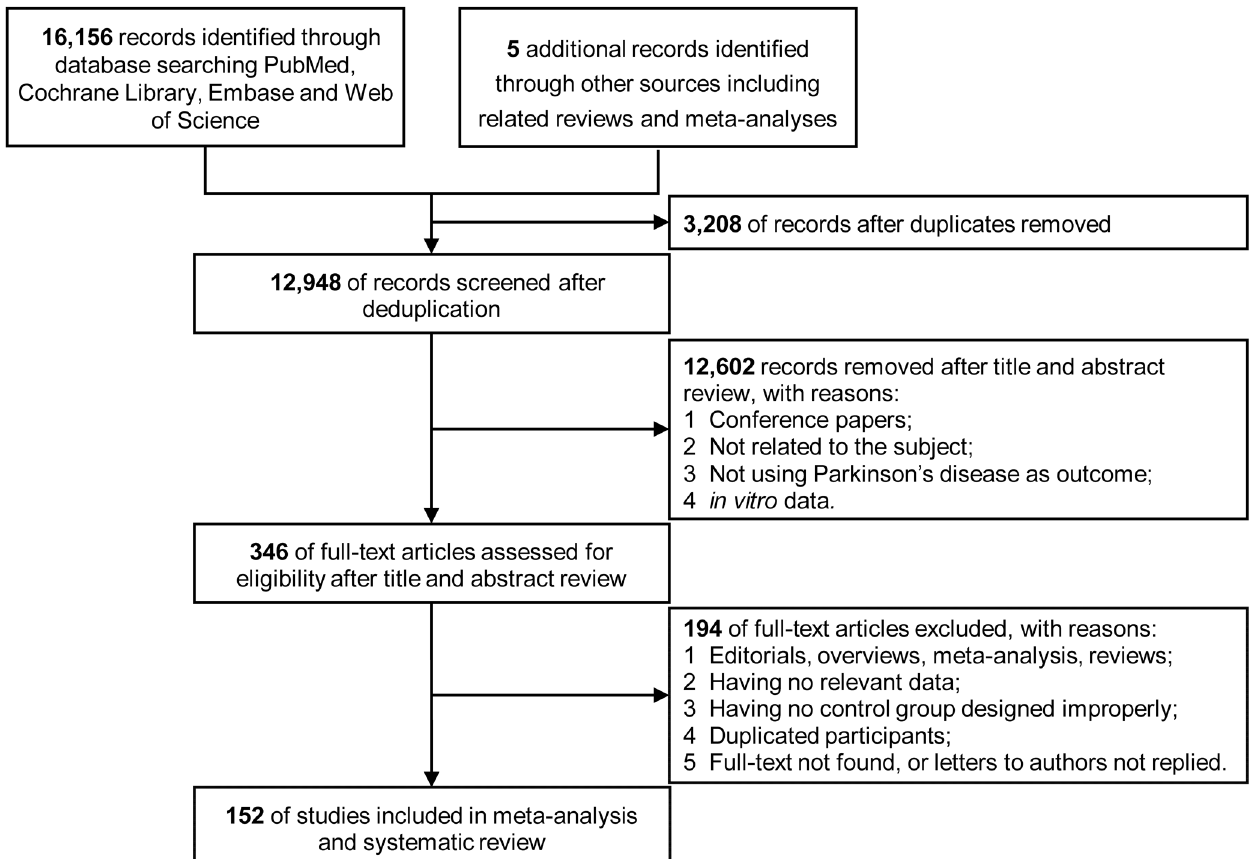
Fig. 1 Flowchart of study inclusion and exclusion. A total of 16,161 records were identi fi ed. After literature searching, selection and deduplication, 152 studies measuring peripheral blood or CSF in fl ammatory markers were fi nally included in the systematic reviews and